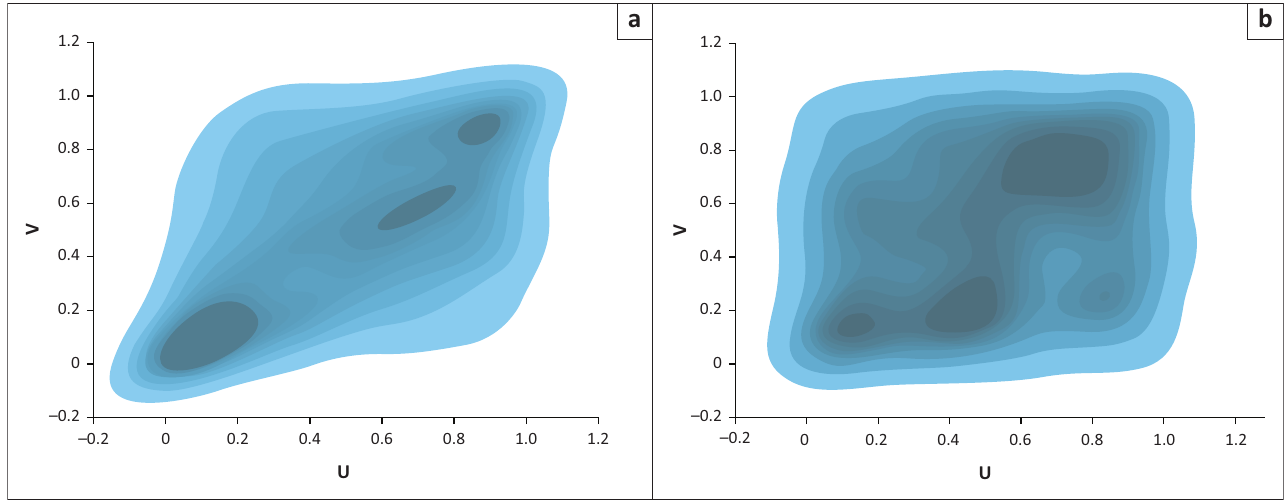
FIGURE 10: Contour plots of the dependence structures observed for Sasol (SOL) and OIL where the N14-copula is used to model the 6-month period ending June 2010 and the Ali-Mikhail-Haq copula captures the dependence for the 6-month period ending December 2020